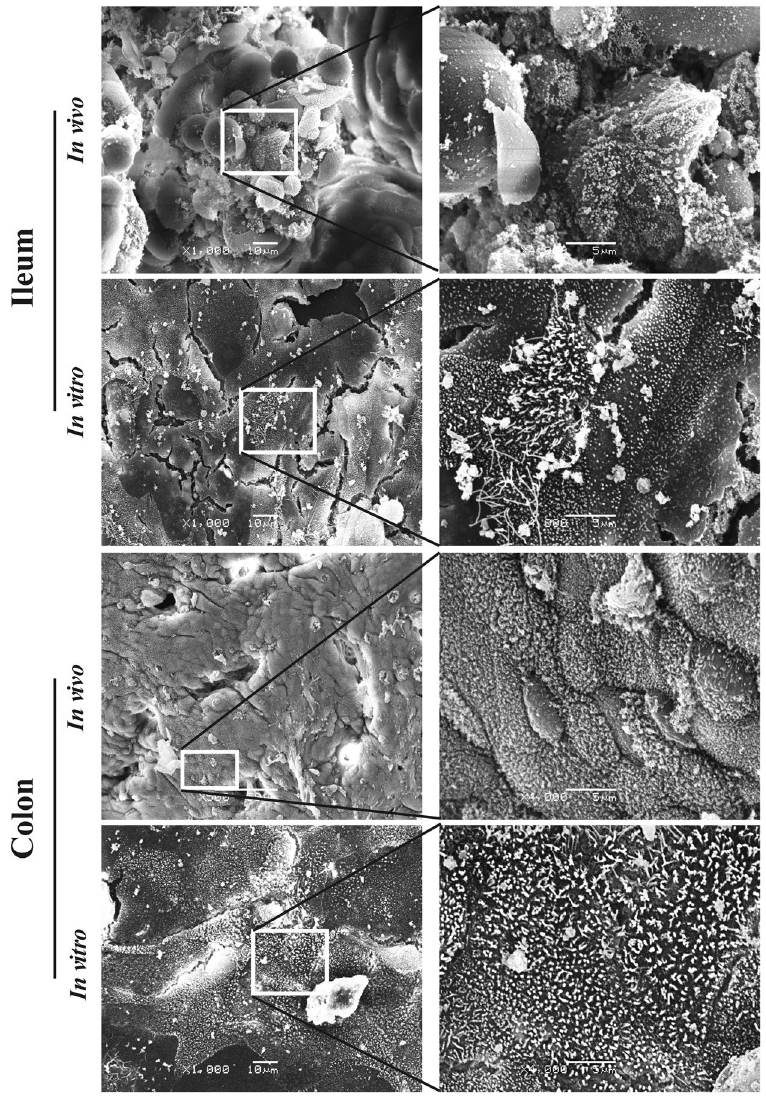
Figure 5. Scanning electron micrographs of ileum and colon epithelial cells in vivo and in vitro . Microvilli are present on a few epithelial cells at the top of an ileum villus of a 3 days old piglet. Cultured ileum epithelial cells are covered with microvilli. In the colon of a 3 days old piglet, almost all the epithelial cells were covered with short microvilli. A large number of microvilli were present on the colon epithelial cells at 3 days post